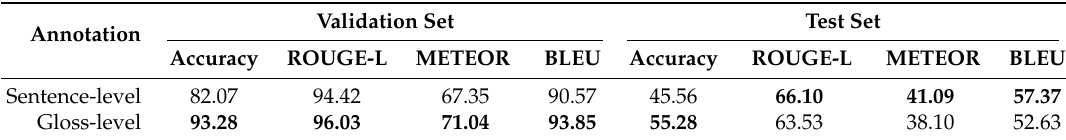
Table 3. Comparison of sign language translation performance on different types of annotations. Note that bold numbers represent the best performance results.